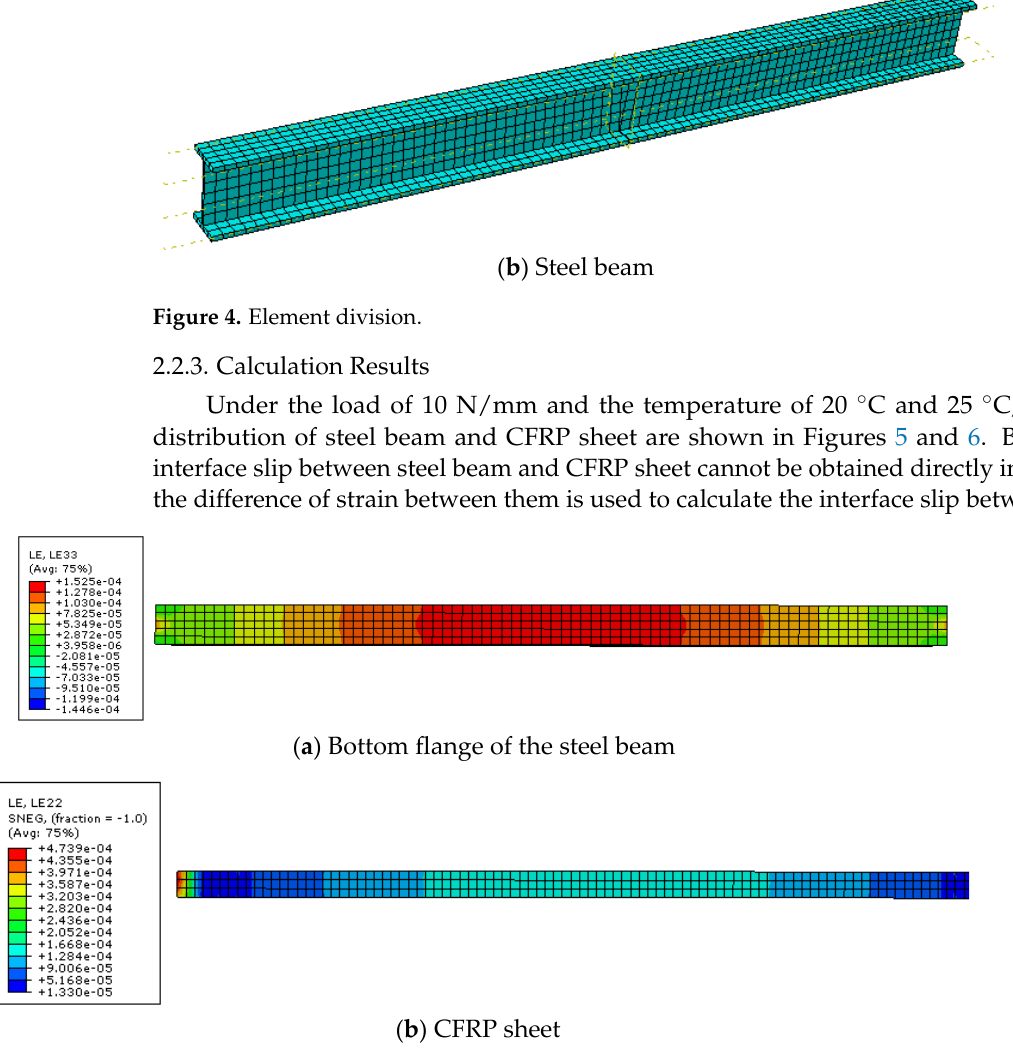
( b ) CFRP sheet Figure 6. Strain distribution at a temperature of 25 °C. The comparison between finite element calculation and formula calculation results is shown in Figure 7. It can be seen from the figure that the two are in good agreement, indicating that the deduced formula is correct and can be used to calculate the interface slip between steel beam and CFRP sheet. ( a ) Temperature of 20 °C -0.00500.0050.010.015 0.02 0.025 0